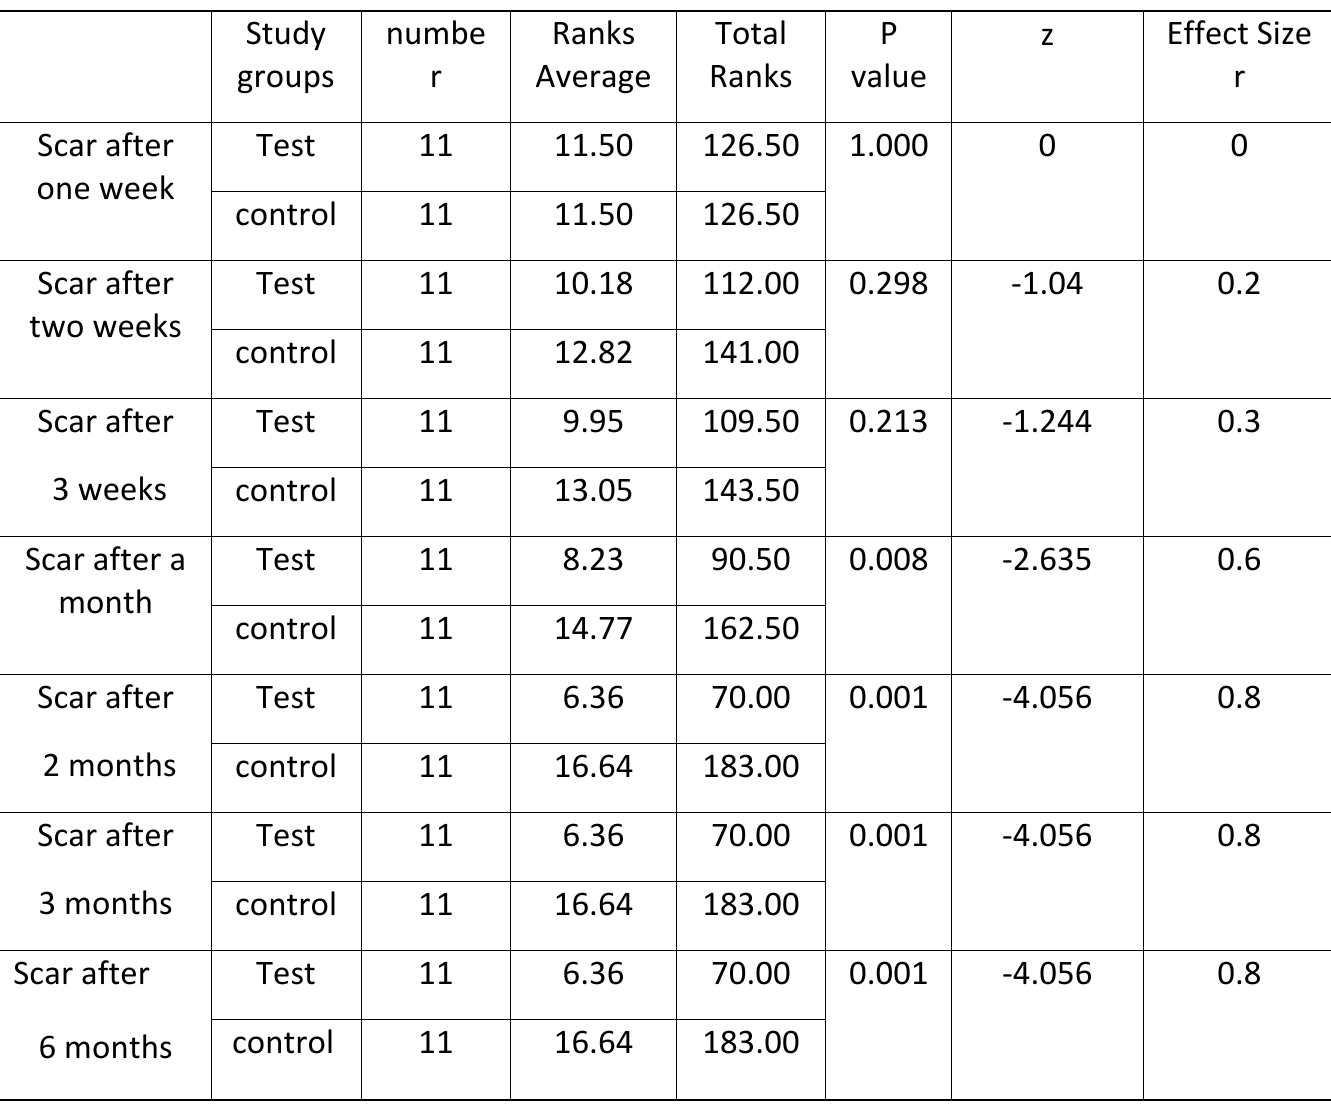
Table 1 contains the results of mucosal scarring index (MSI) after 1, 2, 3, 4 weeks and after 2, 3, 6 months. A positive significant difference was observed between the two groups after one month (p= 0.008, effect size Table 1: Scarring index in the receiving